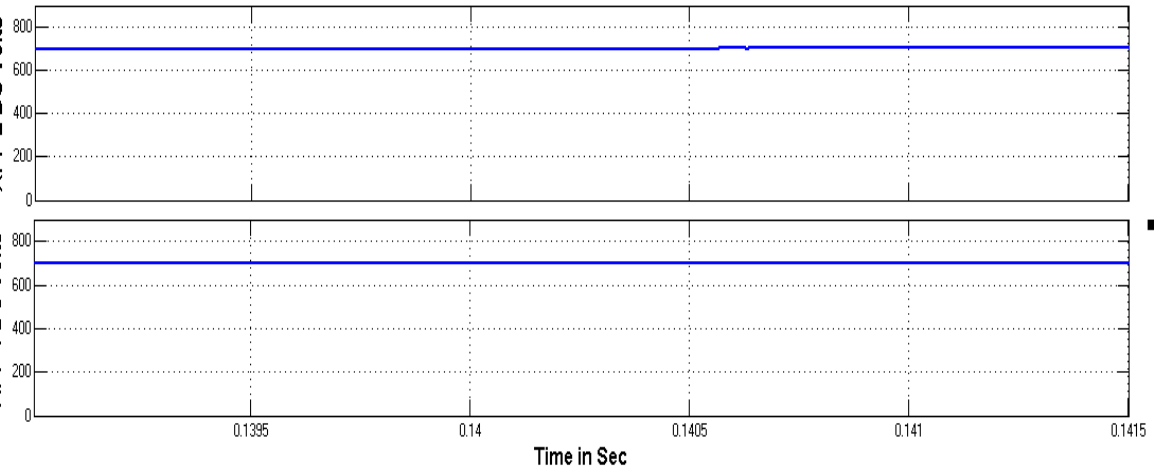
Figure 22. DC link Voltage of APF-1 and APF -2